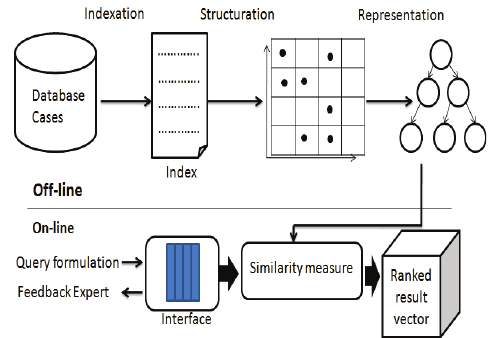
Fig. 1. Retrieval process